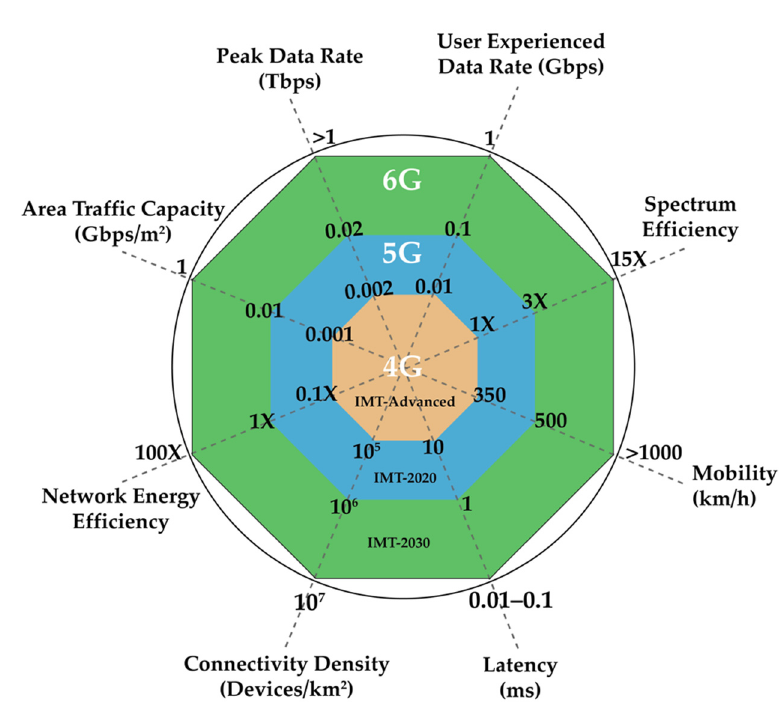
Figure 2. Key capabilities of 6G networks [48] .